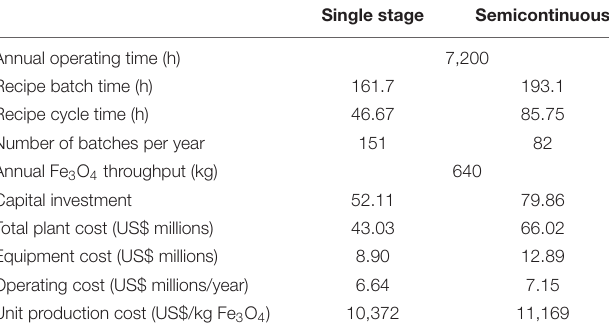
TABLE 3 | Overall bioprocess parameters and economic evaluation